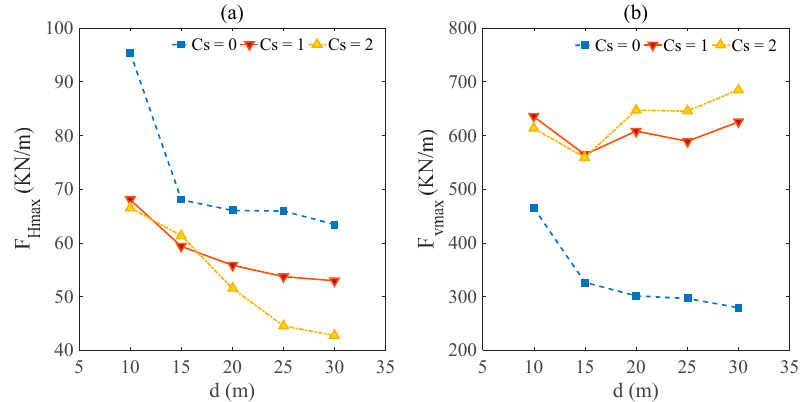
Figure 13. ( a ) Maximum horizontal force ( F H max ) and ( b ) Maximum uplift force ( F v max ) Maximum wave forces versus wave depth ( d ) for the case of box girder under three different submerged coefficients ( C s ).